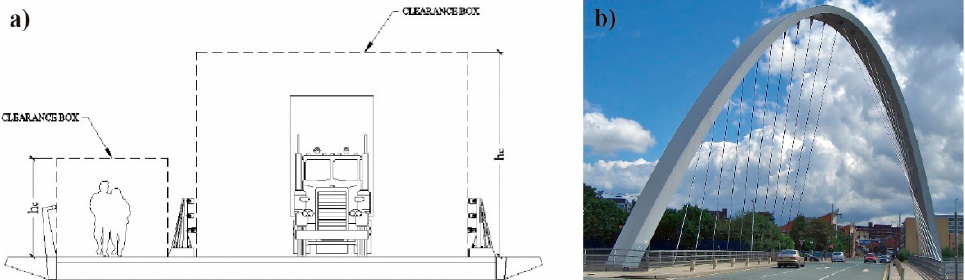
Figure 22. ( a ) Transversal section of a typical bridge with vehicle and pedestrian traffic and ( b ) Hulme Arch Bridge (photo, Mike Peel, Wikimedia Commons).